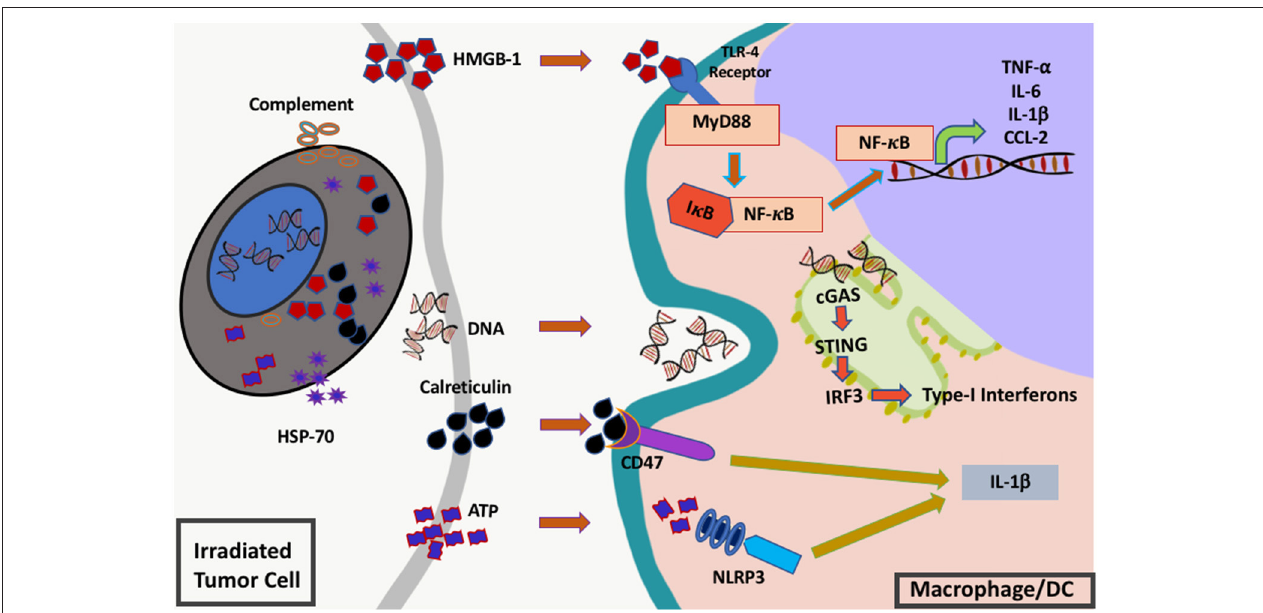
FIGURE 2 | Innate immune signals (“danger signals”) triggered by RT. RT induces the release and activation of multiple different inflammatory mediators from injured cells including complement, heat shock protein 70 (hsp70), high-mobility group box protein 1 (HMGB1), cytosolic DNA, calreticulin, and adenosine triphosphate (ATP). These molecules are sensed by innate immune cells such as macrophages or dendritic cells via toll-like receptor 4 (TLR-4), cyclic GMP-AMP synthase (cGAS)-stimulator of interferon genes (STING), CD47 and NLR family pyrin domain containing protein 3 (NLRP3). Once sensed these receptors send signals via nuclear factor kappa B (NF- κ B) and interferon regulatory factor 3 (IRF3) leading to downstream cytokine production and subsequent